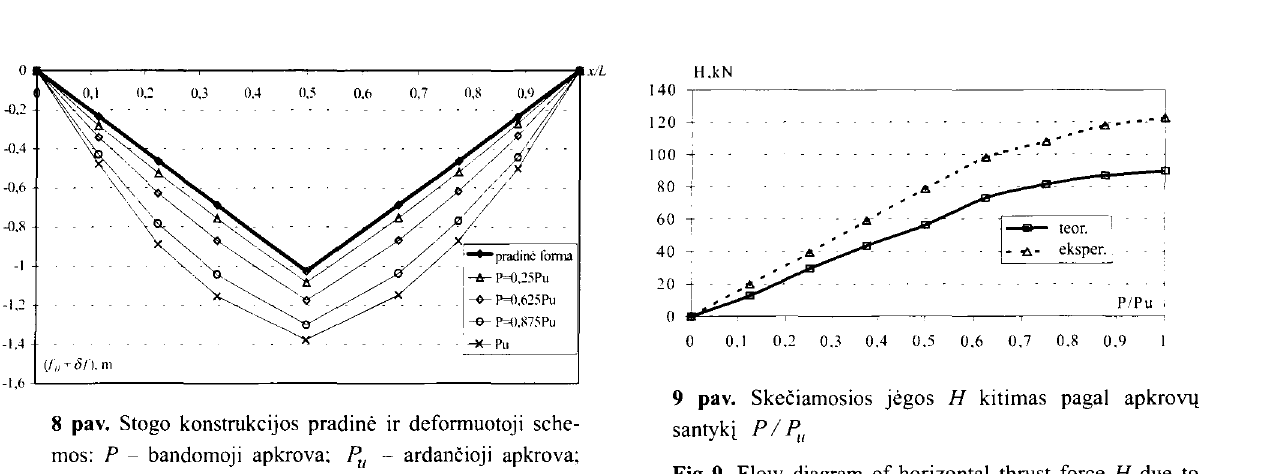
8 pav. Stogo konstrukcijos pradine ir deformuotoji sche mos: P - bandomoji apkrova; P,, - ardancioji apkrova; Fig 9. Flow diagram of horizontal thrust force H due to x - apkrovos prideties taskll atstumas nuo kairiosios at the loading ratio PIP,, ramos; L - tarpatramio ilgis Fig 8. Initial and deformed flow diagrams of roof struc tempiami. Todel j4 ribiniam biiviui nustatyti biitina at ture: P - test load; P,, - failure load; x - distance of sizvelgti ir i asin~ jeg(!. IS ties4 taikant tokio ribinio loading points from left support; L - span length biivio nustatymo metodik<! reikia atsizvelgti i sudeting(! itempil!. biivi, atsiradusi pasireiskus tarpusavio S(!veikai kiekvienam apkrovimo atvejui (8 pav.). Kaip matyti, tarp abiej4 apkrauto skerspjuvio dali4 - isorinio itin konstrukcijoje atsirado dideli statieji poslinkiai. Sie po plonasienio plieno kevalo ir vidines tusCiavidures beto slinkiai maksimaliis buvo element4 viduryje (tarpatra no serdies. Bandymai parode, kad konstrukcija suiro, mio ketvirciuose). Vidurinio mazgo statusis poslinkis di kai laikancittil!. element4 kevalo itempiai pasieke plieno dejo daug leciau nei minet4 pjuvi4. Todel, projektuo ribini tempiam<Ui stipri (triiki) ir kevalas triiko. Tuomet jant tokio tipo kabamuosius stogus, reikia atsizvelgti i plieno kevalo plastines deformacijos buvo itin dideles, tai. kad labai issikreivinantys elementai gali suzaloti pa klot(! ir juos tenka dimensionuoti pagal tinkamumo (II) lo tempiamojo ruozo prie element4 atramini4 mazg4 ribini biivi. (7 pav. 1, tenzojutiklis Nr. 4) bei element4 vidurio, t. y. Kabam4i4 stog4 ribini4 staci4i4 poslinki4 didumai tarpatramio ketvirciuose (7 pav. 2, tenzojutiklis Nr. 9), nera grieztai apibrezti, nes kiekvienu atveju jie priklau skerspjiiviuose (I 0 pav). so nuo bendrosios stogo konstrukcines schemos bei pa kloto konstrukcijos ir medziag4. Pagal [5], ribinis kon strukcijos tarpatramio vidurio iJinkis Of gaJi biiti Irna mas lygus L/300 tarpatramio daliai (jeigu stogo kon strukcija surinkta is skyd4 ir nera vientisine). Bandyto sios konstrukcijos ribinis ilinkis, pagal [5], turi siekti 35,5 mm. Todel galima teigti, kad bandytoji konstruk cija pasieke tinkamumo (II) ribini biivi, kai apkrova sudan~ p = 3,4 kN/m. Kai apkrova yra asimetrine, ribi nis bet kurios konstrukcijos vietos ilinkis gali biiti pa didintas iki tarpatramio L/ 150 dalies. Tuomet miis4 at veju jis siekt4 71 mm. Toks ilinkis atitiko apkrov(! p = 4,91 kN/m. Kai ji buvo p = 9,80 kN/m, vienas is element4 suiro apie I m nuo atramos nutolusiame pjiivyje triikus tempiamojo ruozo plieno kevalui. Pagal [ 4] apskaicuota element4, kaip lenkiamttil!., Fig 10. Normal stress-strain diagrams of tension and ribine apkrova yra p = 7,20 kN/m. Toks gana didelis compression zones of steel shell (at the middle of mem 11 skirtumas gali biiti paaiskintas tuo, kad bandytieji be ber): 4, 9, I 0 - numbers of tenzoresistors due to Fig 7, tonserdziai elementai yra ne tik lenkiami, bet ir